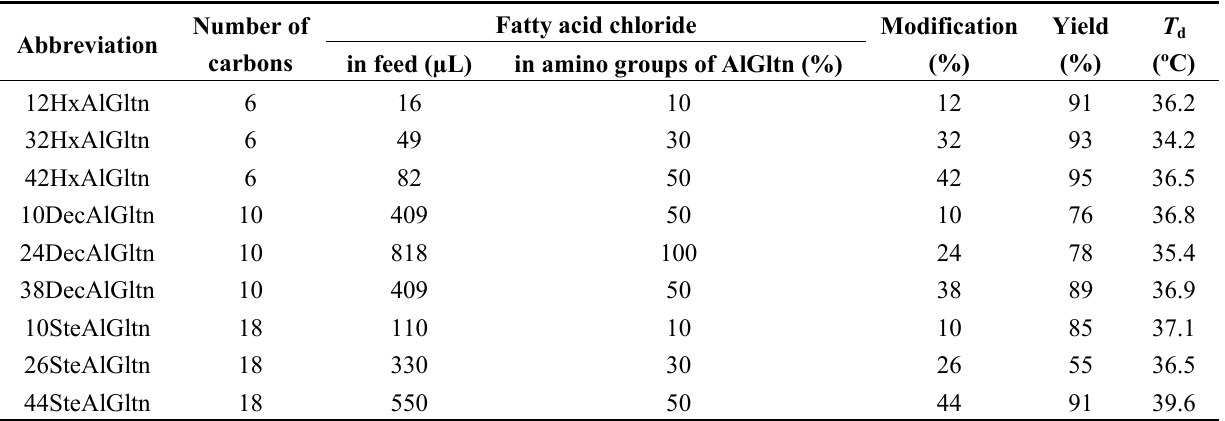
Table 1. Hydrophobically modified alkaline-treated gelatin films (hm-AlGltns) with various modification